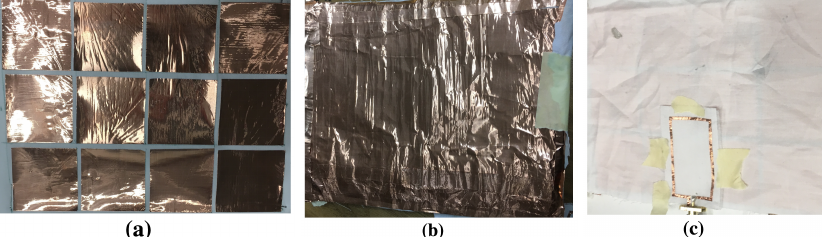
Figure 18. Images of the fabricated wearable loop antenna with HIS structure, ( a ) embedded HIS metallic patches, 4 × 3 elements, ( b ) HIS metallic ground plane, and ( c ) wearable loop antenna on top of HIS structure. Note that insulating tape was used to remove any air gaps between the